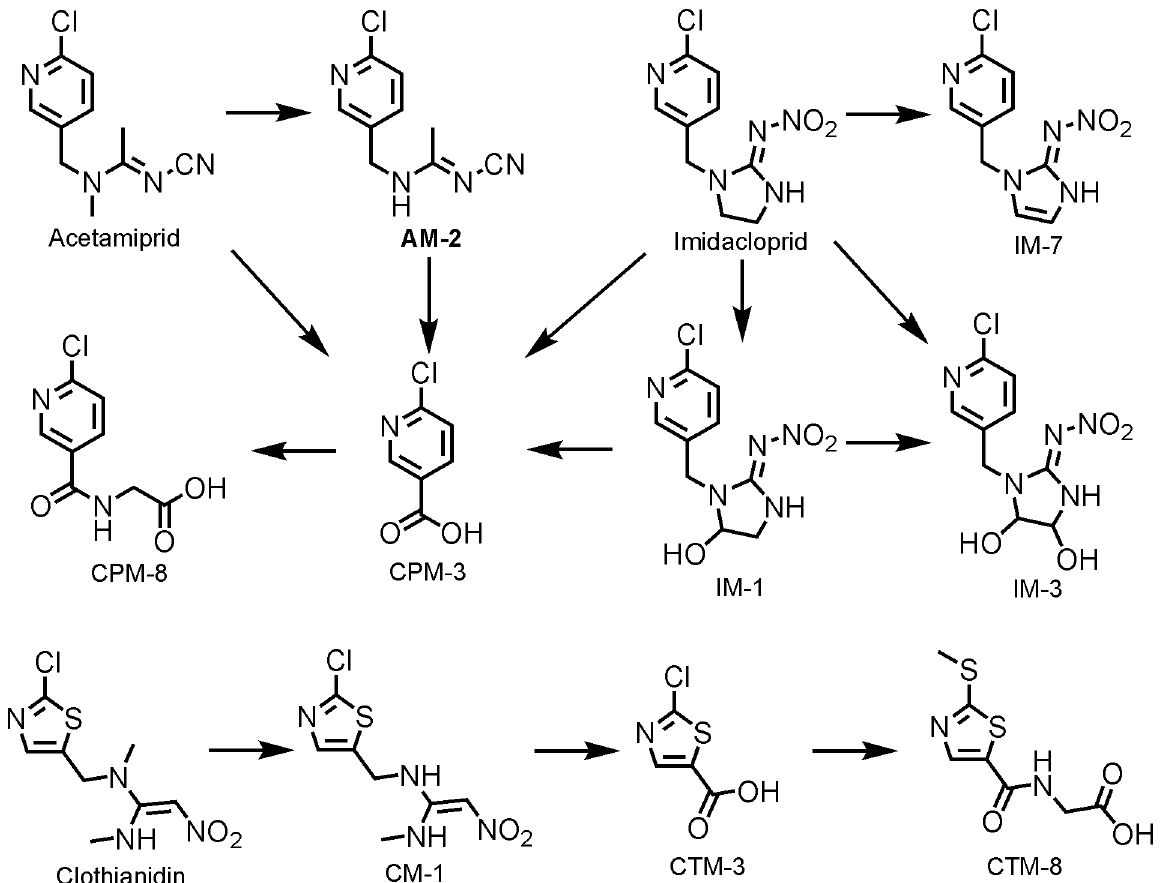
Figure 1. Chemical structures of neonicotinoid insecticides, imidacloprid, acetamiprid and clothianidin, and selected